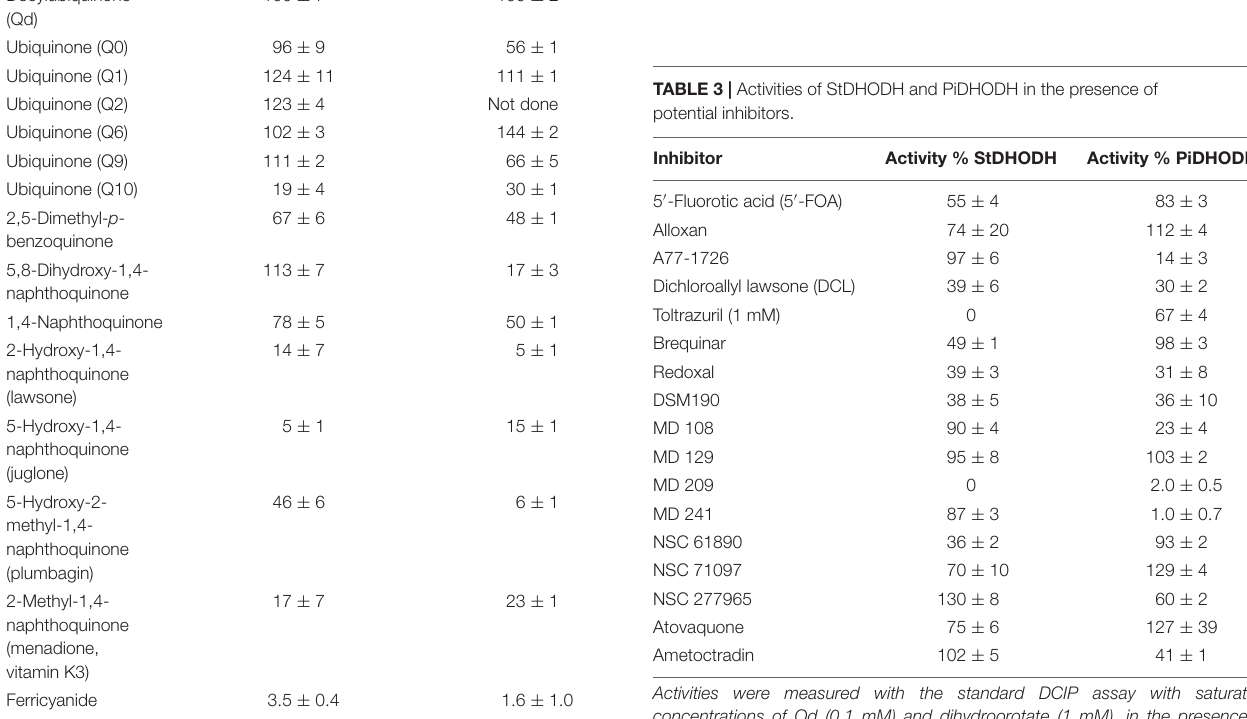
Activities were measured with the standard DCIP assay with saturating concentrations of Qd (0.1 mM) and dihydroorotate (1 mM), in the presence of 0.5 mM inhibitor, unless otherwise indicated. The activity without inhibitor was set as 100%. Compounds that increase activity above 100% apparently acted as electron acceptors instead of